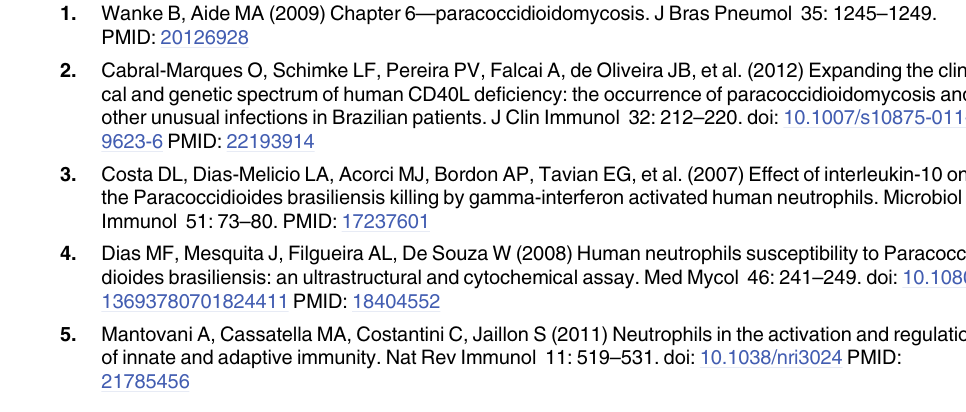
S1 Fig. Subcutaneous air-pouches of the Saline groups. Clinical appearance of the air- pouches on the dorsum after skin flap procedure in mice inoculated with: A — saline; and B — saline followed by LLLT. Both groups reveal no neutrophil